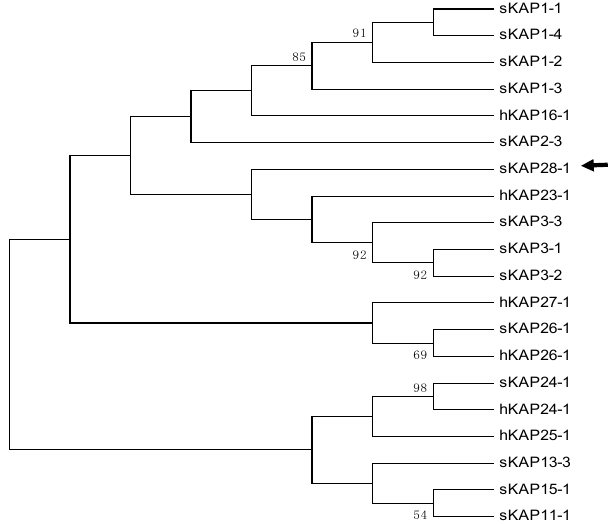
Figure 1. Phylogenetic tree for high sulphur keratin-associated proteins (HS-KAPs) that have been identified in sheep, along with human HS-KAPs. The tree is assembled using amino acid sequences. The sheep KAPs are specified with an “s” prefix, while the human KAPs are specified with an “h”. The numbers at the forks show the bootstrap confidence values, with only those equal to or greater than 50% being shown. The newly identified sheep KAP28-1 gene is marked with a horizontal arrow. The GenBank accession numbers for all other sheep KAPs are: NM_001159760 (sKAP1-1), HQ897975 (sKAP1-2), NM_001159761 (sKAP1-3), GQ507741 (sKAP1-4), P02443 (sKAP2-1), U60024 (sKAP2-3), M21099 (sKAP3-1), M21100 (sKAP3-2), M21103 (sKAP3-3), HQ595352 (sKAP11-1), JN377429 (sKAP13-3), KX817979 (sKAP15-1) and JX112014 (sKAP24-1). The accession numbers for the human KAPs are: NM_181623 (hKAP15-1), NM_001146182 (hKAP16-1), NM_181624 (hKAP23-1), NM_001085455 (hKAP24-1), NM_001128598 (hKAP25-1), NM_203405 (hKAP26-1) and NM_001077711 (hKAP27-1).